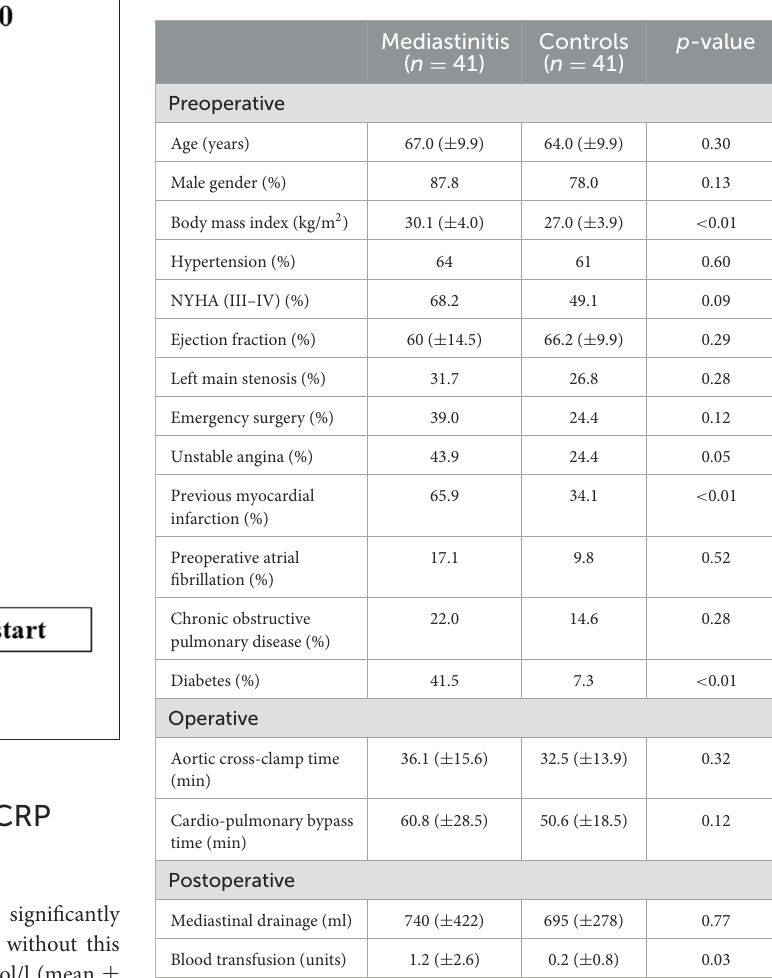
TABLE 1 Clinical profile of patients with mediastinitis and random controls without